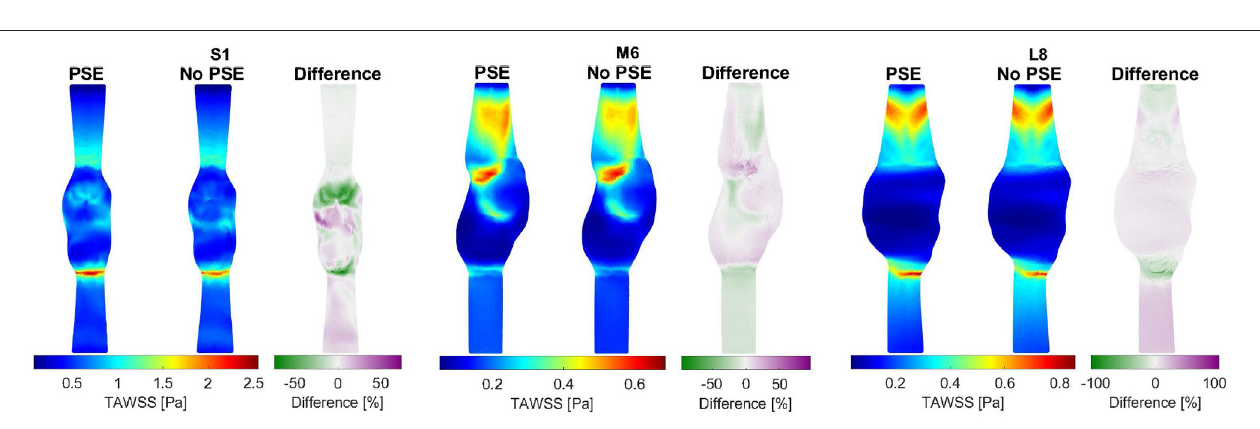
absolute spatial difference equals 14.7%, as shown in Figure 11D